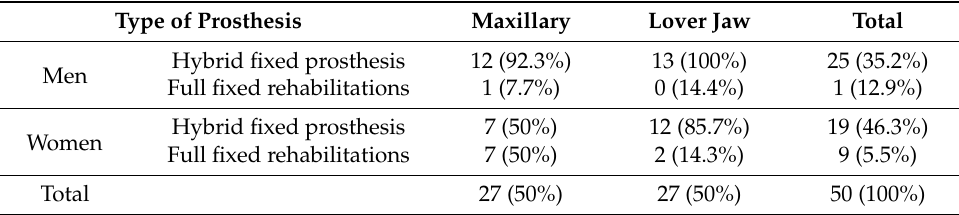
Table 5. Distribution of the type of prostheses according to the sex of the patients ( p = 0.0161).